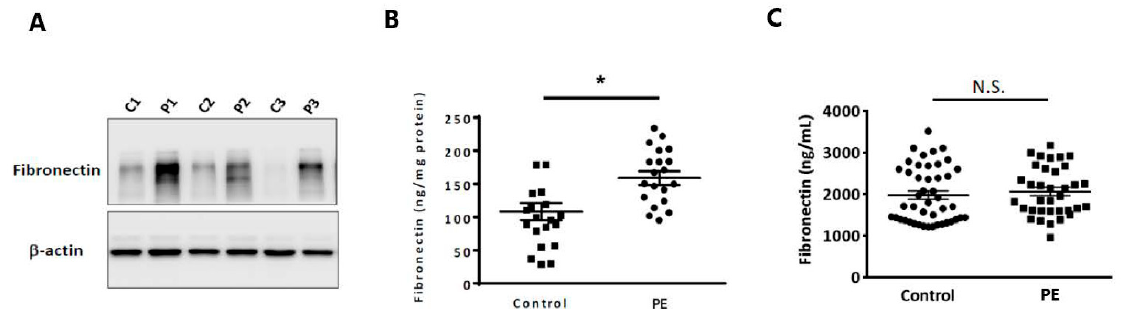
Figure 1. Placental fibronectin (FN) expression is elevated in patients with preeclampsia. The protein concentration of FN in the placenta was measured in preeclamptic patients (P1-3 and PE) and women with normal pregnancies (C1, C1, C3, and control) using ( A ) Western blotting (n = 3 in both groups) and ( B ) ELISA (n = 20 in both groups). ( C ) The plasma FN concentration was measured in preeclamptic patients (n = 35) and normal controls (n = 45) using ELISA. Data are presented as the means ± SEMs. N.S. denotes no significance, * p < 0.05 compared with the corresponding